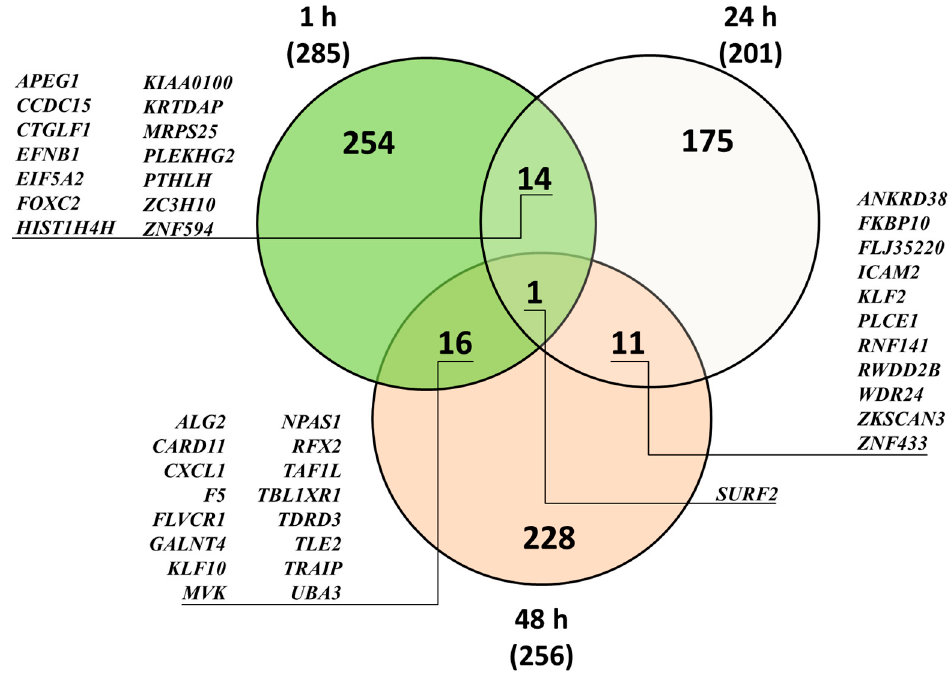
Figure 2. Venn diagram of HDFa whole genome modulated transcripts upon DMSO treatment. Expression level was assessed by microarray analysis. Numbers in parentheses represent the amount of DEGs (FC ≤ 0.7 and FC ≥ 1.3) for each time point, n = 3. Numbers in overlapping parts of diagram represent shared genes (listed).